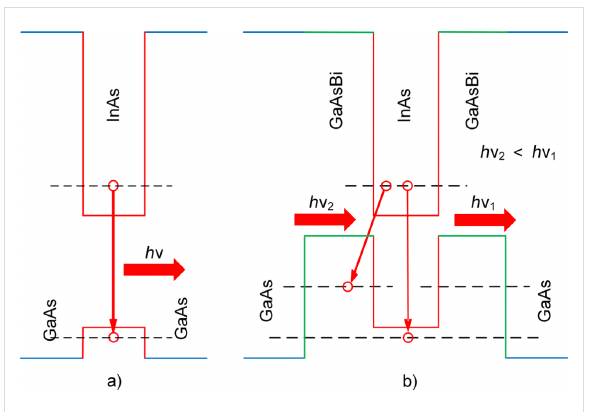
Figure 5: Energy band diagram of heterostructures: a) InAs/GaAs; b) InAs/GaAs 1 − x Bi x .